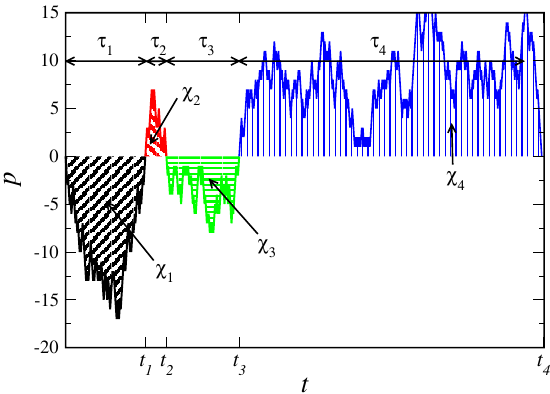
FIG. 2. Schematic presentation of the momentum of the particle versus time. The times between consecutive zero crossings are called the waiting times τ , and the shaded area under each excursion are the random flight displacements χ . The τ ’ s and the χ ’ s are correlated since a long waiting time typically implies a large